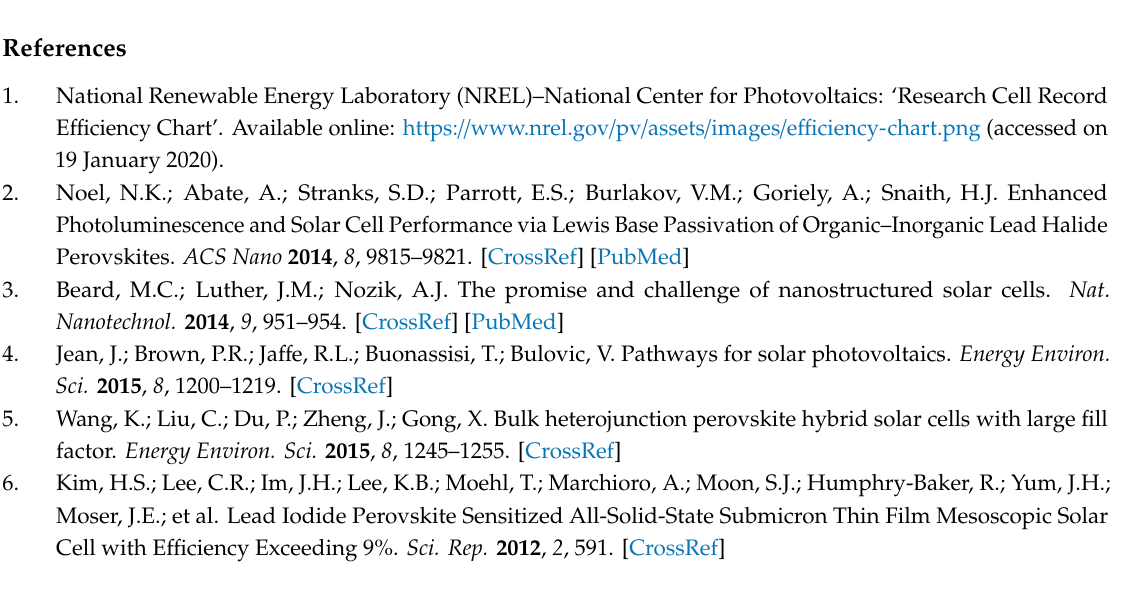
Figure S1: Photocatalytic system, Figure S2: Colorimetric titration by titanyl on MA 2 CuCl 2 Br 2 , Figures S3, S4 and S5: XPS analysis of MA 2 CuCl 2 Br 2 , Figure S6: H 2 generation of hybrid lead halide perovskites, Scheme S1: Energy Level positions, Figure S7: VB determination of MA 2 CuCl 2 Br 2, Figure S8: Temporal evolution of H 2 generation for MA 2 CuCl 2 Br 2 perovskite, Figure S9: Temporal evolution of H 2 generation for MA 2 CuCl 2 Br 2 and MA 2 CuCl 0.5 Br 3.5 perovskites, Figure S10: Evolution of the optical absorption spectrum of the MA 2 CuCl 2 Br 2 upon laser